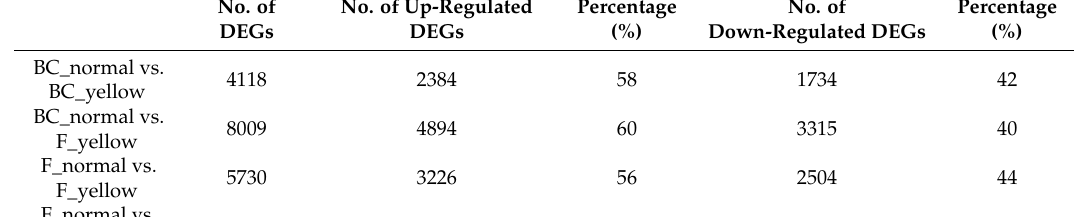
Table 2. Numbers of DEGs between the yellow-leaf and normal-leaf samples.